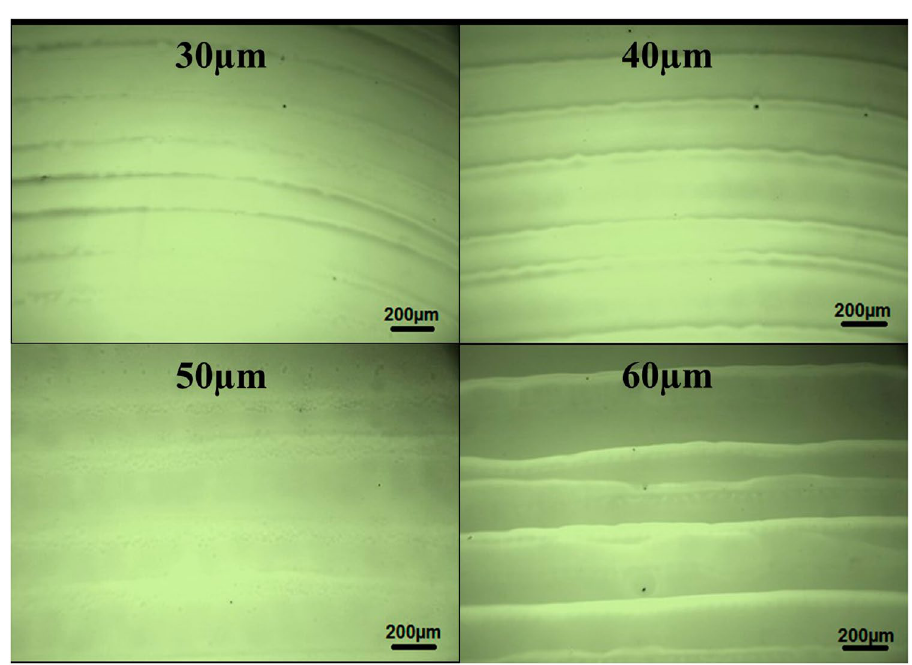
Figure 2. Optical images of inkjet printed NiO films at different drop spacing (30, 40, 50 and 60 μ m) on UV- Ozone treated ITO/Glass